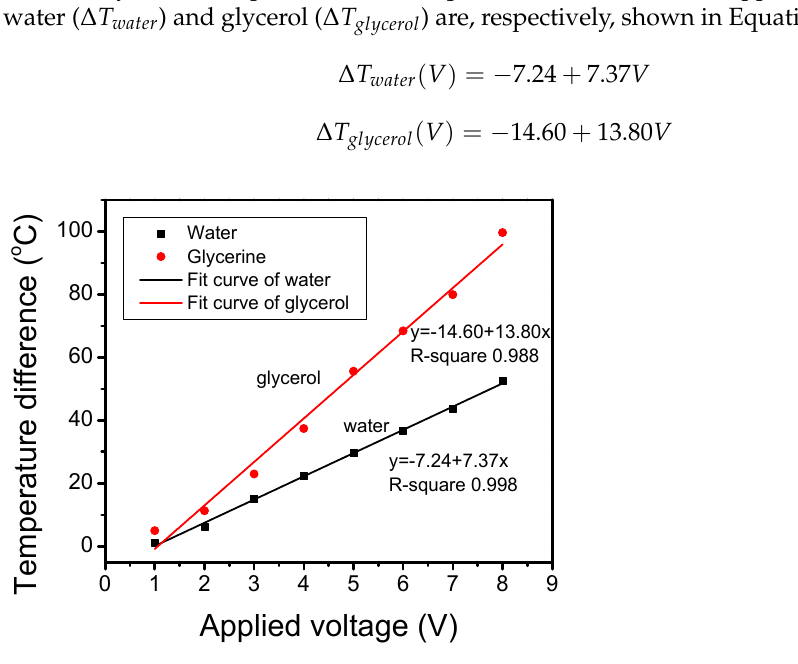
Figure 3. Thermal equilibrium temperature for water and glycerol as a function of applied voltages.